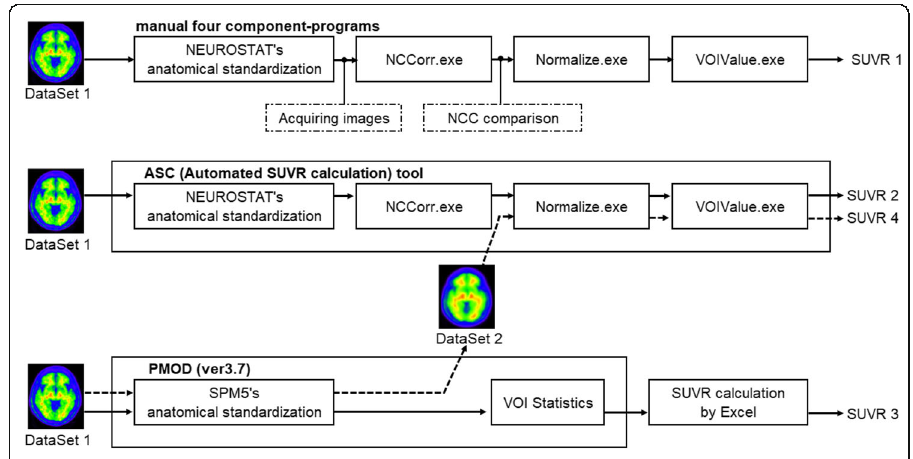
Fig. 2 Compared methods for calculating SUVRs. From top to bottom, manual four-component programs, ASC tool, and a combination of conventional programs. A combination program included PMOD and Microsoft Excel for manual calculation of SUVR. The PMOD included SPM5 for anatomical standardization and VOI Statistics for ROI analysis. Dataset 1 is input images to ASC tool and PMOD. Dataset 2 is anatomically standardized images using PMOD. The calculated SUVRs are referred to as SUVRs 1, 2, 3, and 4